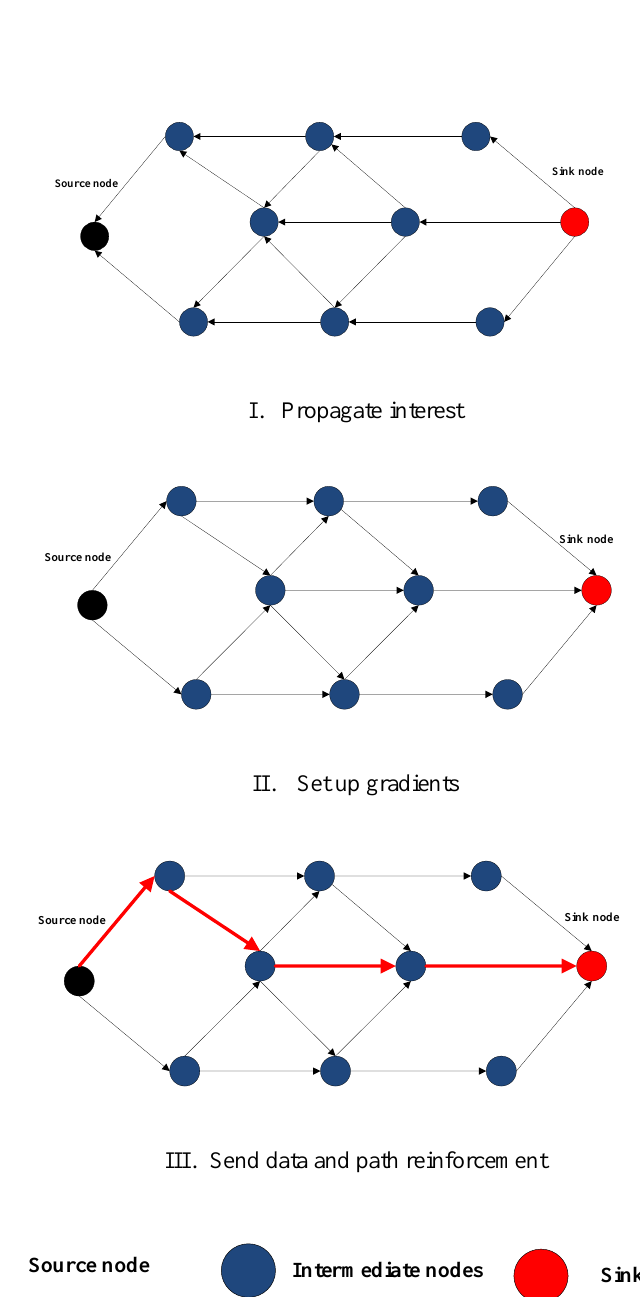
Figure 5. Direct diffusion example from source to sink displayed in I, II and III